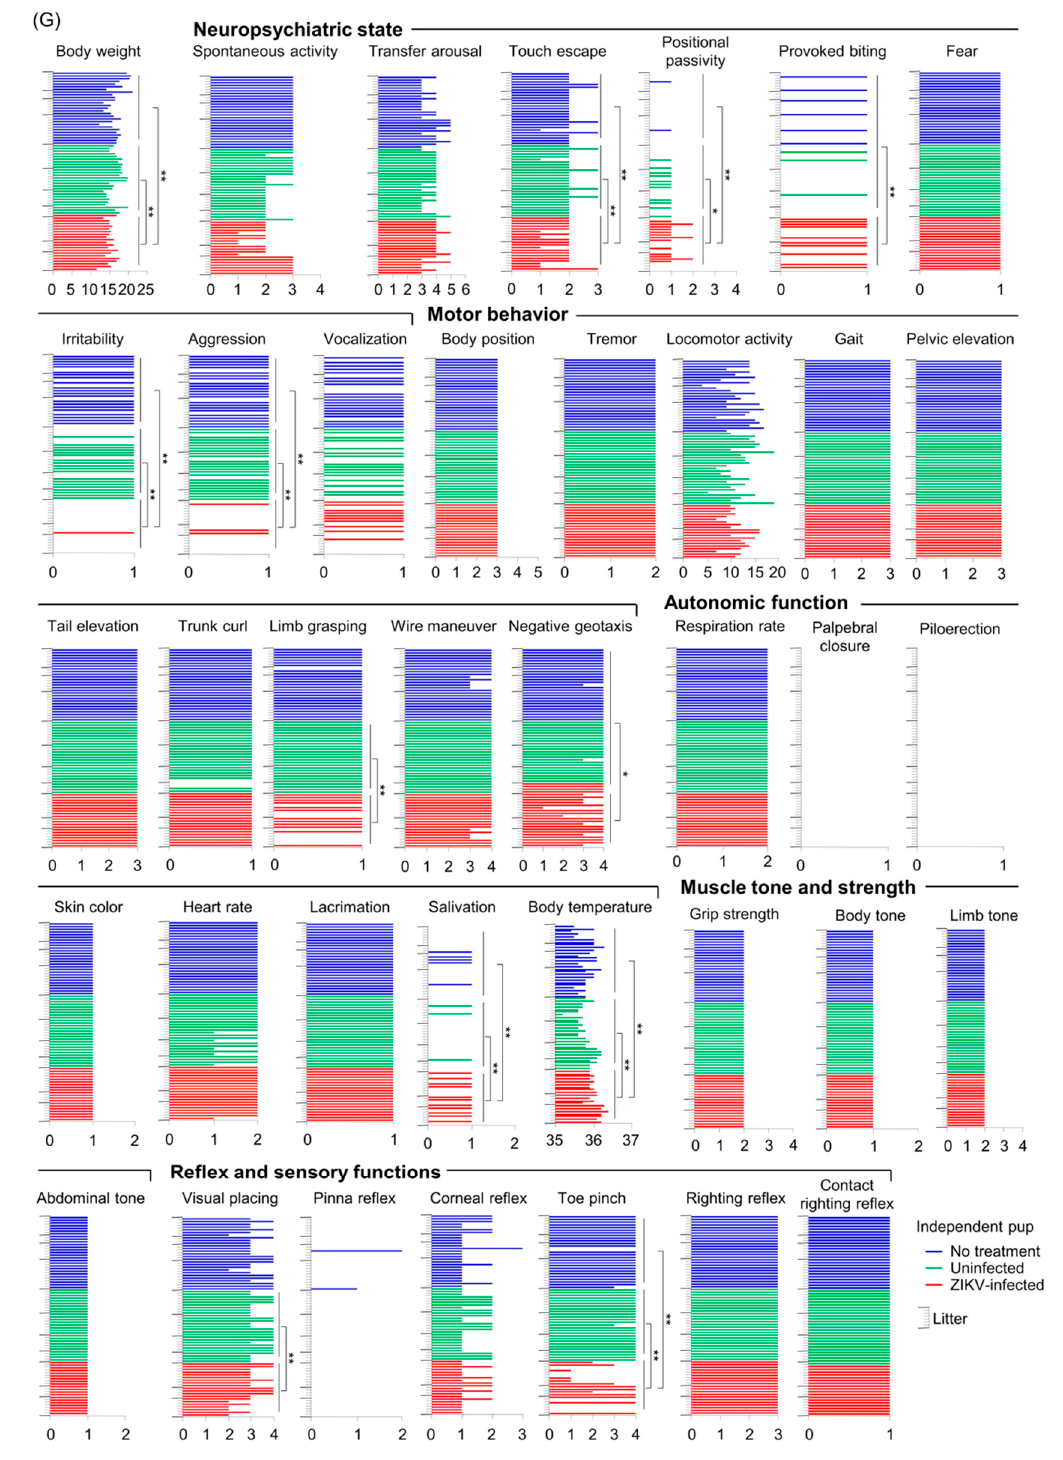
Figure 3. Postnatal outcomes. ( A ) Survival of offspring. Data are from 8 offspring from 1 dam infected at E8.5, 16 offspring from 3 dams infected at E9.5, 12 offspring from 2 dams infected at E10.5, 14 offspring from 2 dams infected at E11.5, 75 offspring from 9 dams infected at E12.5, 20 offspring from 3 dams infected at E13.5, 25 offspring from 4 dams infected at E14.5, and 19 offspring from 3 uninfected dams. Comparison of Kaplan–Meier survival curves between groups was performed by log-rank analysis. ( B ) Weight of offspring at P3. Individual litters are indicated on the x -axis; each square represents a single offspring. Vertical dashed gray lines separate each litter, which was infected at the indicated embryonic days. The pale green shaded area represents 2SD below the mean body weight of uninfected offspring. ( C ) Weight gain of each litter. The pale green shaded area represents 2SD below the mean body weight of uninfected off-